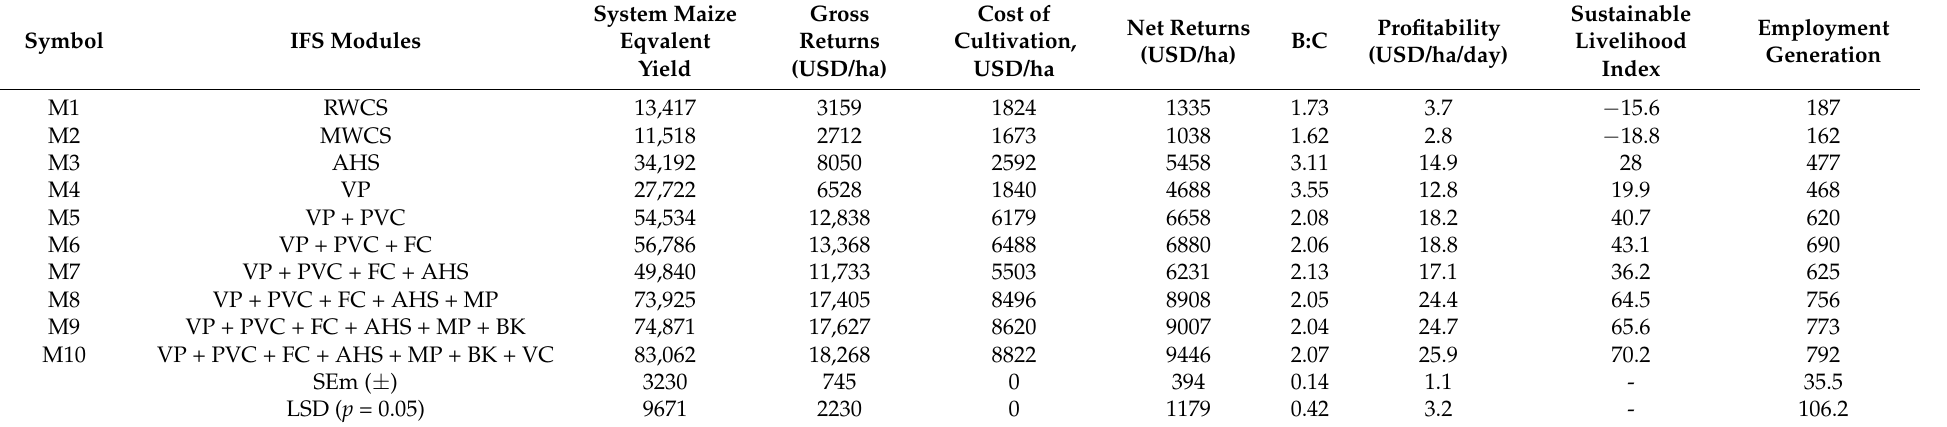
Table 7. System maize equivalent productivity (kg/ha), economics, sustainable livelihood index (%), and employment generation (man-days) of different modules of the integrated farming system.